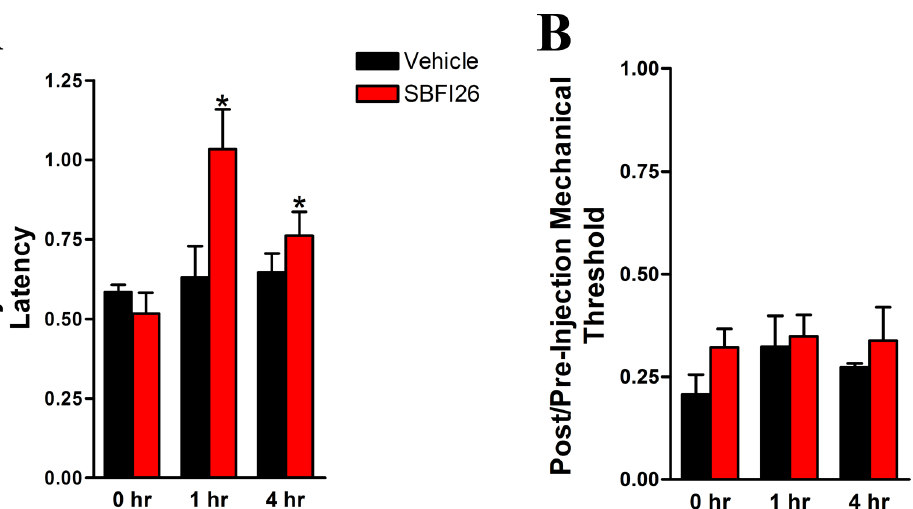
Figure 4. SBFI26 blocks thermal hyperalgesia in a rat model of neuropathic pain. (A) Thermal latencies and (B) mechanical thresholds in rats subjected to CCI were measured following injection of 20 mg/kg SBFI26. SBFI26 was injected at the 0 hr time point and evoked behaviors were measured at 1 and 4 hrs post-administration. The results are expressed as fraction of the pre-injury baseline measurement per animal (mean + / 2 SEM). Pre-injury thermal latency was 23.5 + / 2 0.7 s and mechanical threshold was 29.9 + / 2 0.6 g (mean + / 2 SEM). Results were analyzed by repeated measures ANOVA followed by Tukey’s post-hoc analysis. *, p , 0.05 versus 0 hr time point (n=6).